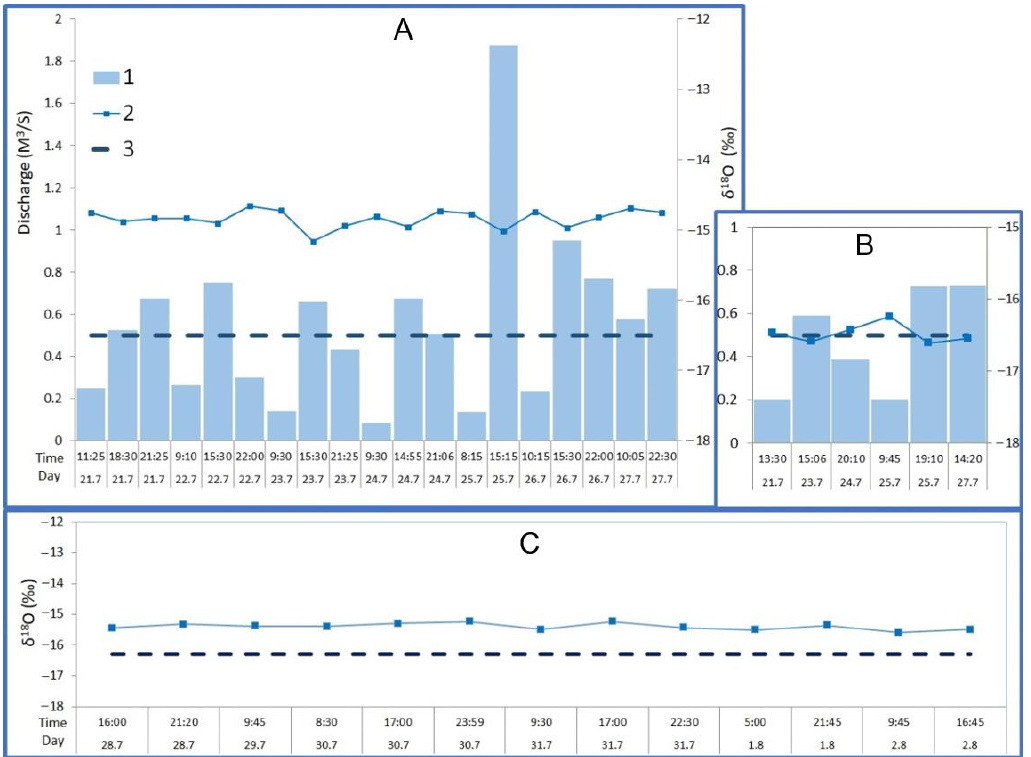
Figure 2. Water discharge and isotopic water composition at Hydrological station No. 1 ( A ), HS No. 2 ( B ), and δ 18 O changes for the melt water near the glacier No. 9 ( C ). 1—Discharge, 2—Isotopic composition of water, 3—average isotopic composition of ice.